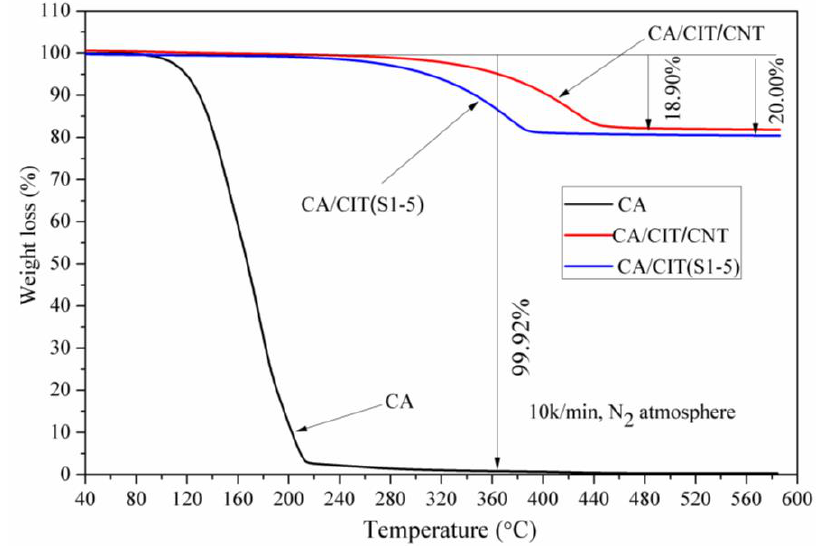
Figure 10. TGA curves of CA, CA/CIT FSPCM, and CA/CIT/CNT FSPCM.